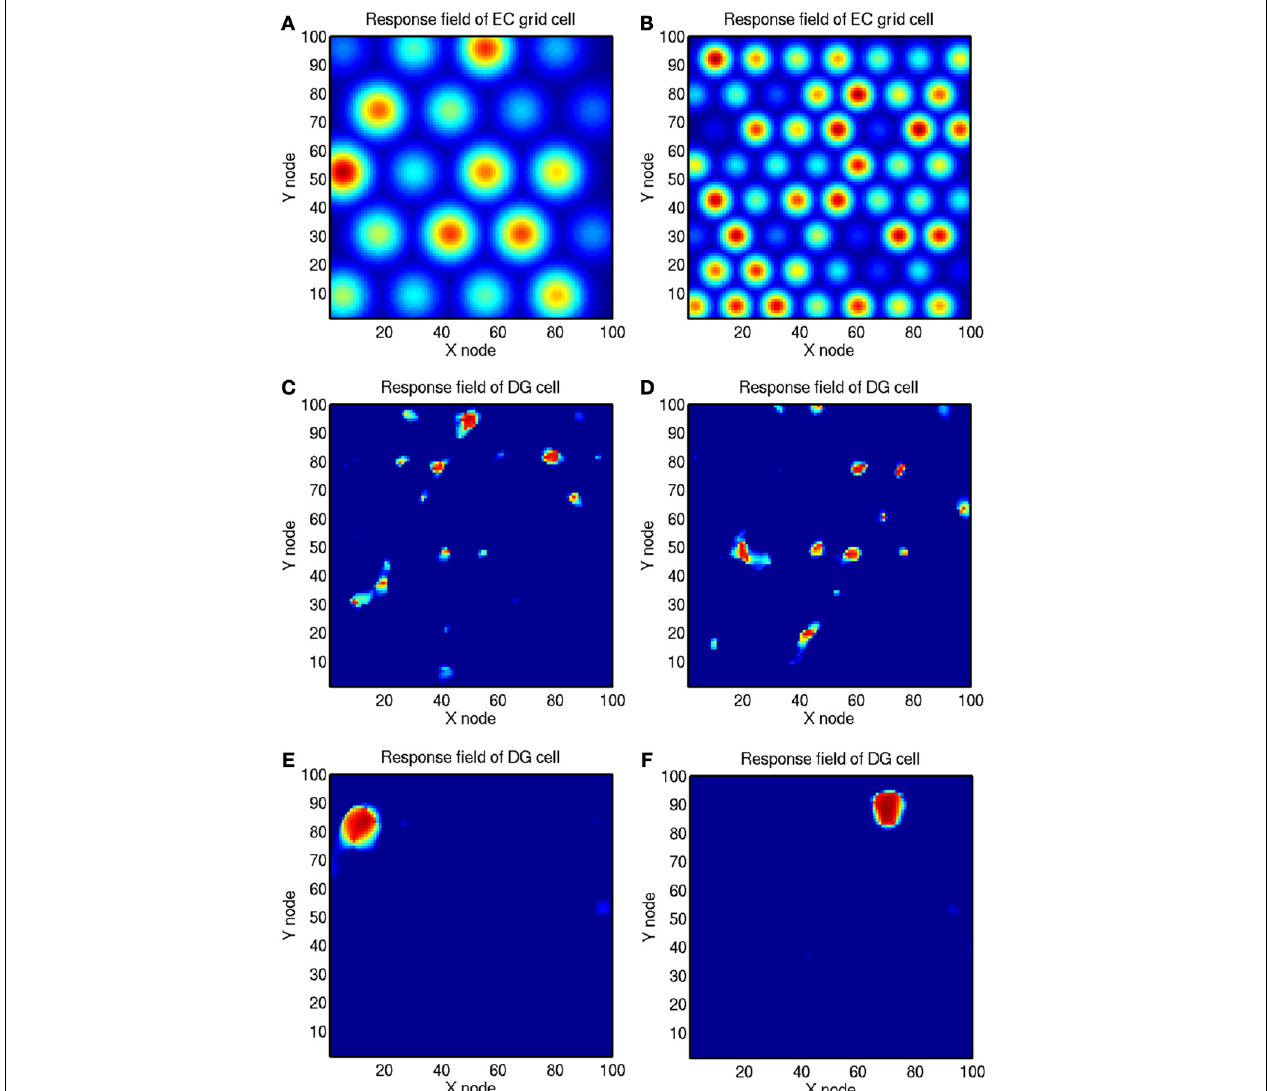
FIGURE 4 | Simulation of competitive learning in the dentate gyrus to produce place cells from the entorhinal cortex grid cell inputs. (A and B) Firing rate profiles of two entorhinal cortex (EC) grid cells with frequencies of 4 and 7 cycles. (C and D)